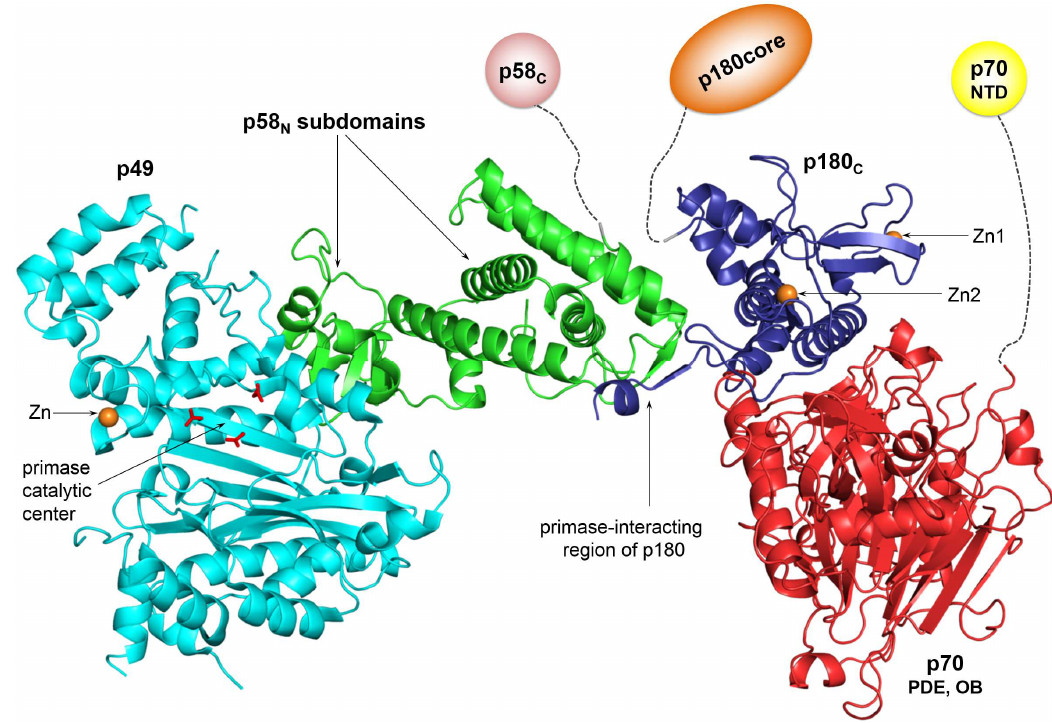
Figure 2. The platform of the human primosome. Coordinates of the human primosome (PDB ID 5EXR) were used to represent the platform structure. The color scheme for domains is the same as in Figure 1. The positions of p58 C and p180core, as well as the linkers connecting them to the platform, vary depending on the primer synthesis step. For space-saving purposes, p58 C , p180core, and p70-NTD are shown at reduced scale relative to the platform. All figures were prepared using the PyMOL Molecular Graphics System (version 1.8, Schrödinger, LLC).